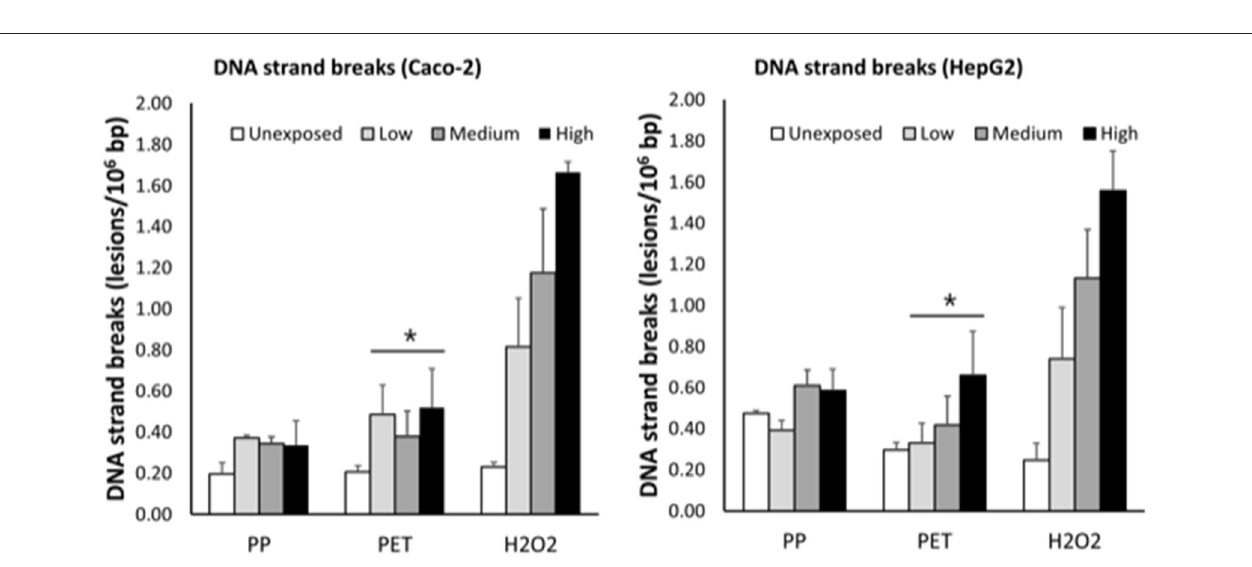
FIGURE 5 | Levels of DNA strand breaks in Caco-2 and HepG2 cells after 3h exposure to grinded particles of polypropylene (PP) and polyethylene terephthalate (PET) food containers. The high concentration is 63ng/ml, 175ng/ml, and 100 µ M of PET, PP, and H 2 O 2 , respectively. The medium and low concentrations correspond to sequential two-fold dilutions. Each bar is the mean and SEM of three independent experiments, except H 2 O 2 in Caco-2 cells ( n = 2). * P < 0.05, linear mixed effect model.